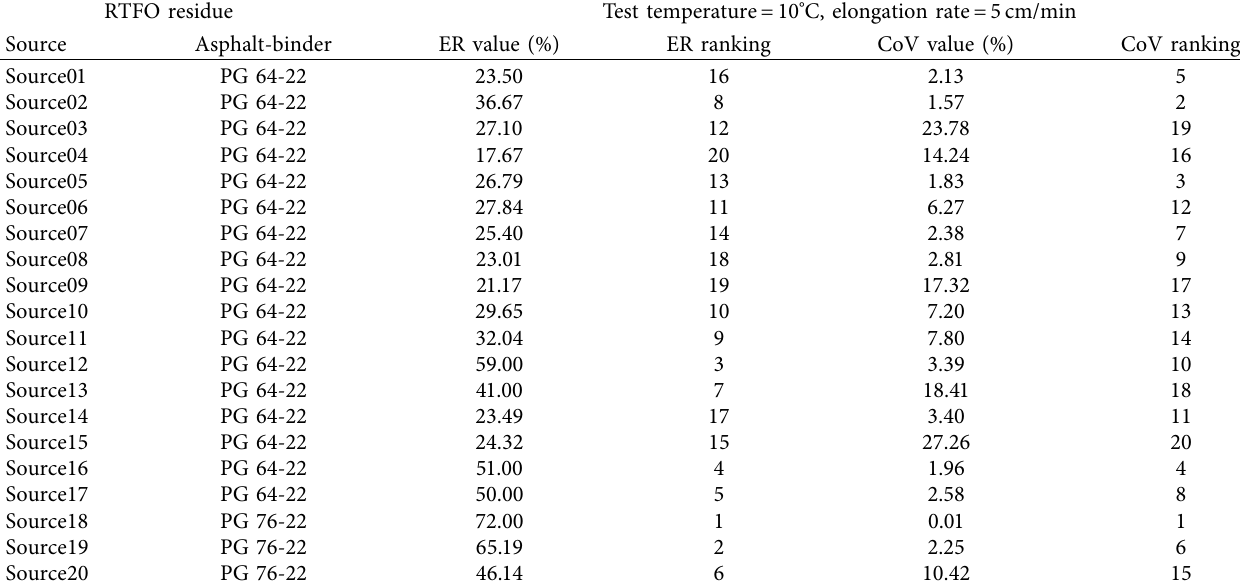
Table 2: ER test